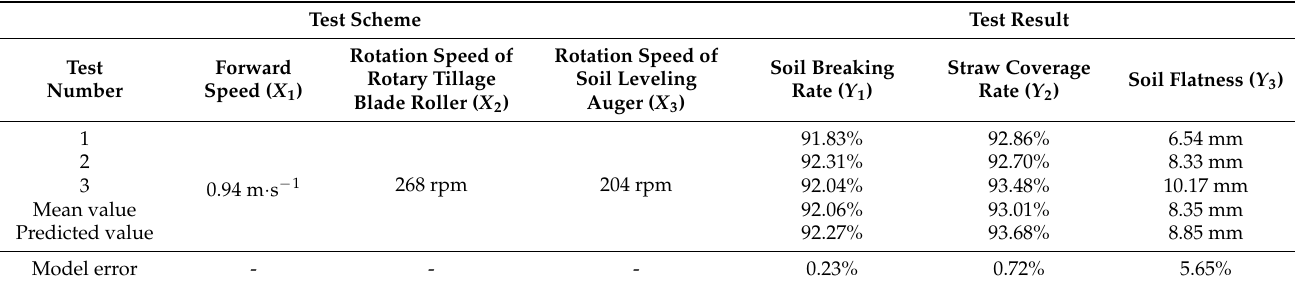
Table 7. Verification test results of seedbed preparation